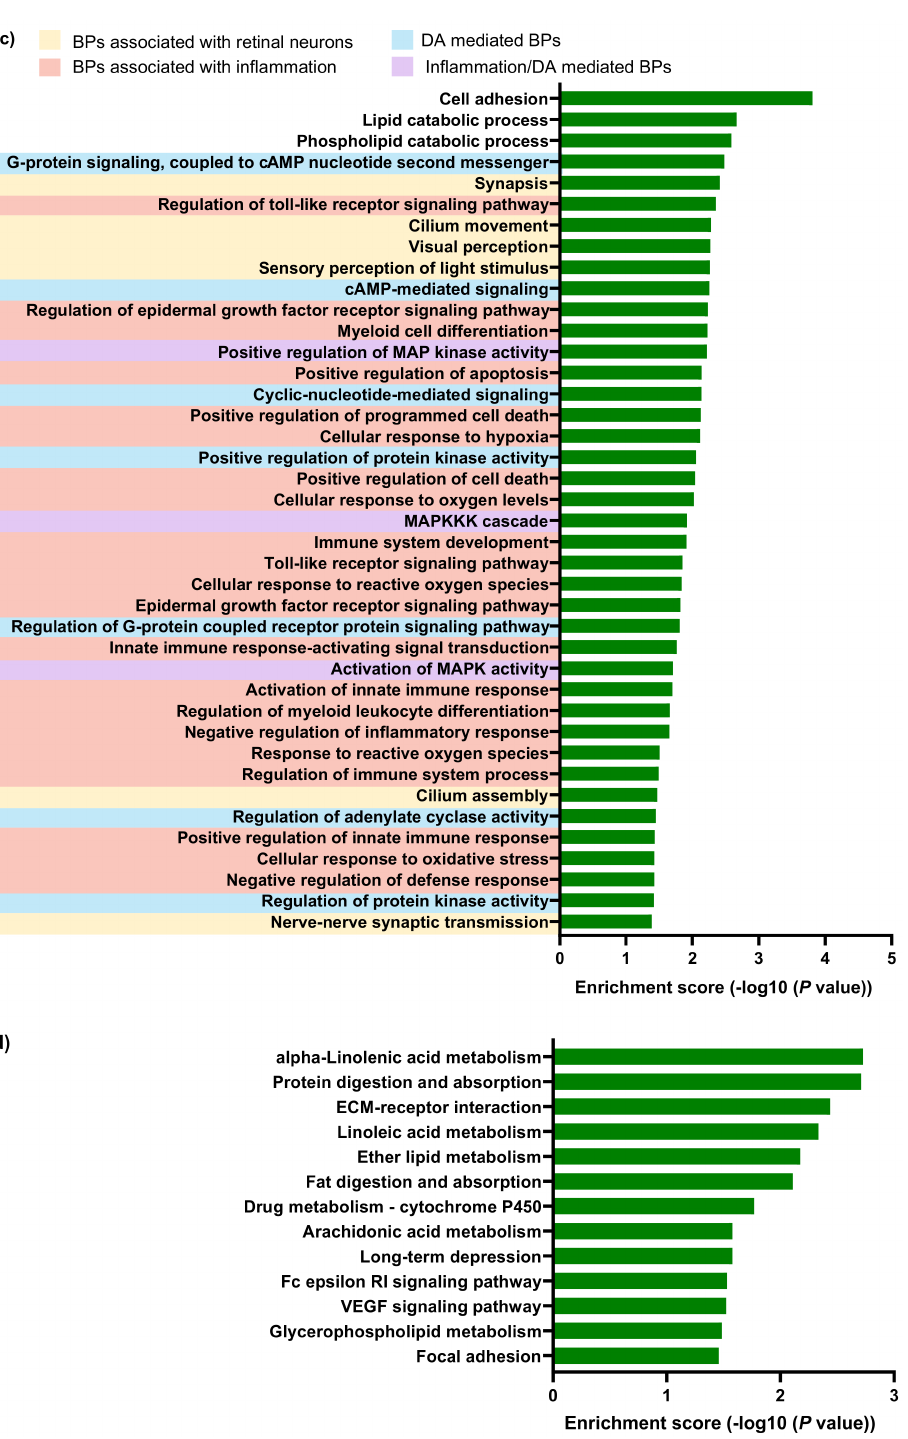
Figure 4. Gene functional annotation in Gnat1 rd17 mice by GO and KEGG. ( a – c ) GO enrichment and ( d ) KEGG pathway analysis of protein-coding DEGs in the neuroretina of Gnat1 rd17 mice vs. WT mice. The statistically significant GO terms ( p < 0.05) for ( a ) molecular function (MF), ( b ) cellular component (CC), and ( c ) biological process (BP) (40 selected GO terms). Individual GO terms associated with DA functions, photoreceptors/retinal neurons, and inflammation are color-coded on the left side of the ordinate. The ordinate represents the GO term or KEGG pathway name, and the abscissa represents the enrichment score calculated as the negative base-10 logarithm of the p -value ( − log10 ( p -value)). The smaller the p -value for the difference, the larger the − log10 ( p